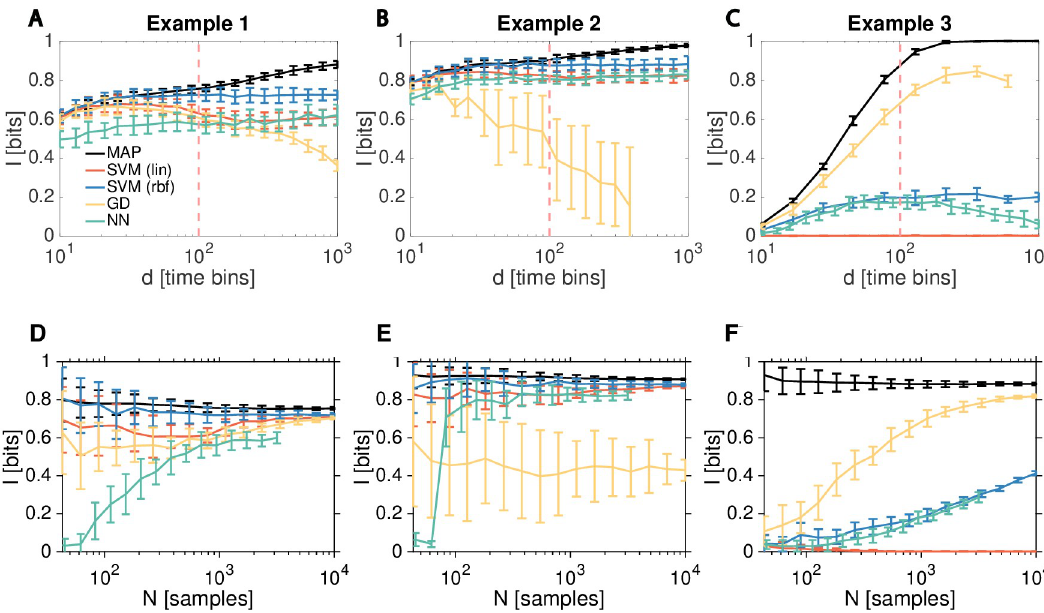
Fig 5. Performance of decoding-based estimators depends on the dimensionality of the response trajectories and on the number of response trajectory samples. Performance of various model-free decoding estimators (colored lines) for Examples 1 (A, D) , 2 (B, E) , 3 (C, F) , respectively, compared to the MAP bound, I MAP (black line), as a function of input trajectory dimension, d (at fixed N = 1000) in A, B, C; or as a function of the number of samples, N , per input condition (at fixed d = 100) in D, E, F. Error bars are std over 20 replicate estimations. Decoding estimators: linear SVM, I SVM(lin) (orange); radial basis functions SVM, I SVM(rbf) (blue); the Gaussian decoder with diagonal regularization (see S2 Fig for the effects of covariance matrix regularization and signal filtering on Gaussian decoder estimates), I GD (yellow); multi-layer perceptron neural network, I NN (green). Dashed vertical orange line marks the d � 100 regime typical of current experiments. Note that while the amount of information must in principle increase monotonically with d , the amount that decoders can actually extract given a limited number of samples, N , has no such guarantee. The decrease, at high d , in Gaussian decoder information estimate in A, B, C and neural network information estimate in C, happens because the number of parameters of the decoder grows with d albeit at fixed number of samples, leading to overfitting that regularization cannot fully compensate, and thus to the consequent loss of performance on the test